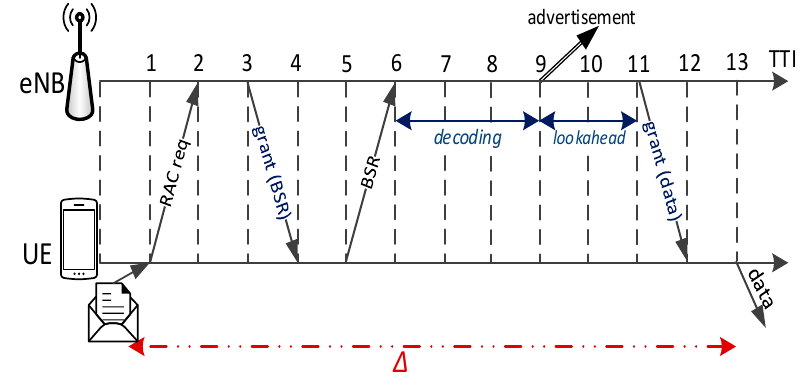
Figure 7. SRA with coordination among eNBs.